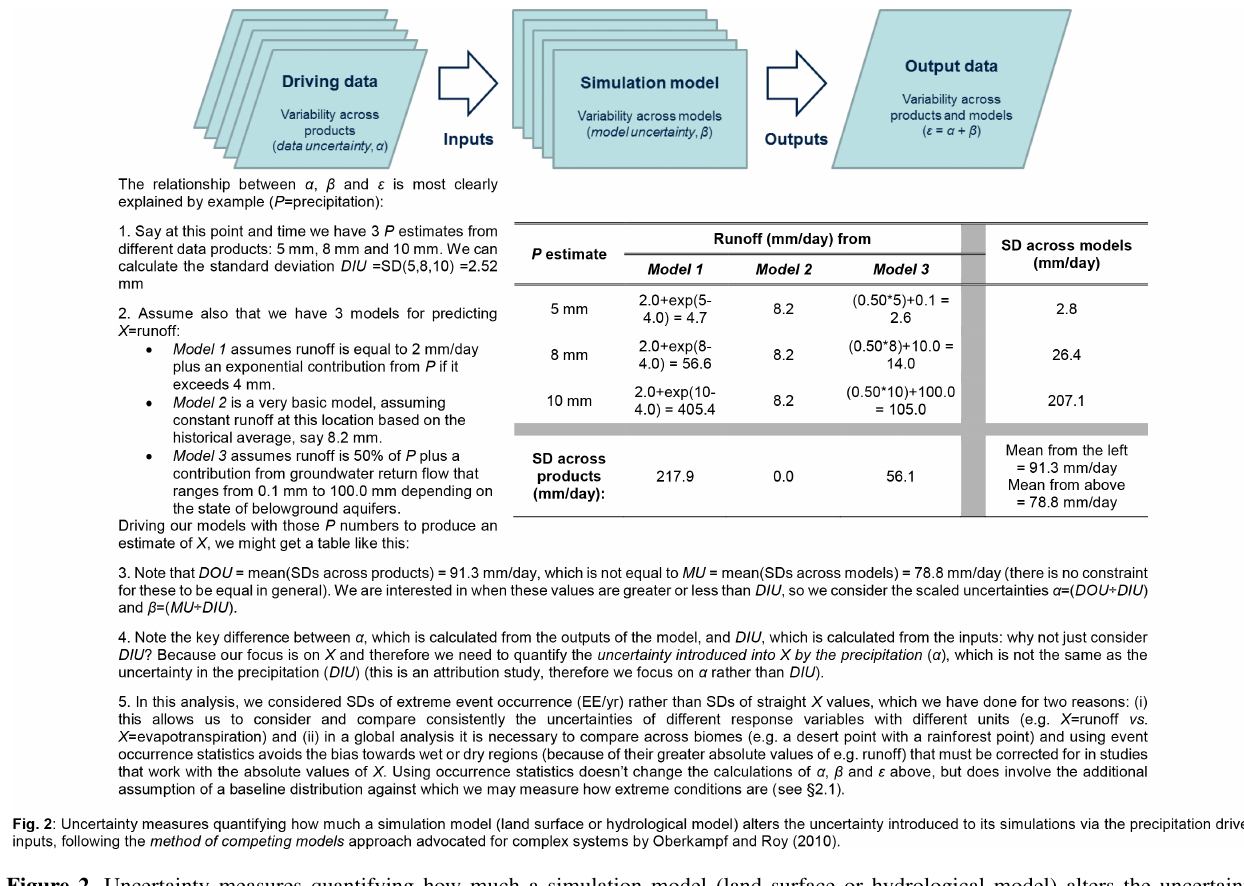
Figure 2. Uncertainty measures quantifying how much a simulation model (land surface or hydrological model) alters the uncertainty introduced to its simulations via the precipitation driver inputs, following the method of competing models approach advocated for complex systems by Oberkampf and Roy